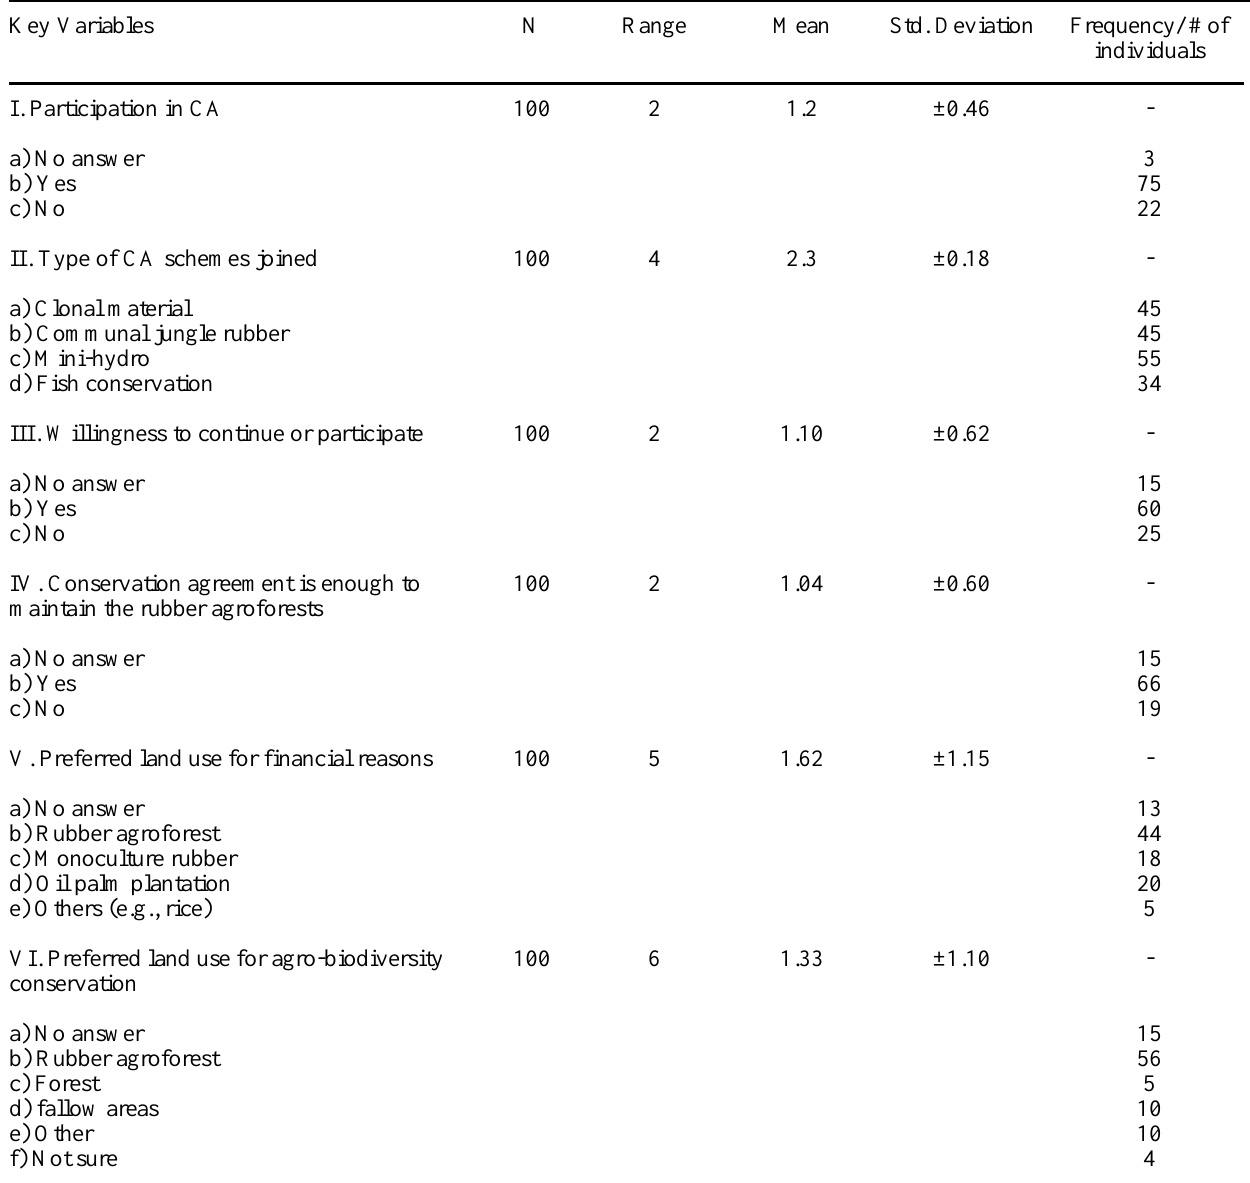
Table 5. Descriptive statistics of the respondents on conservation agreements for 2010 Key Variables N Range Mean Std.